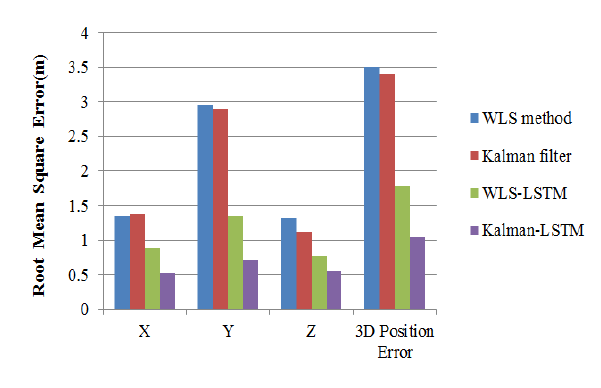
Figure 14. The position error of four different methods.